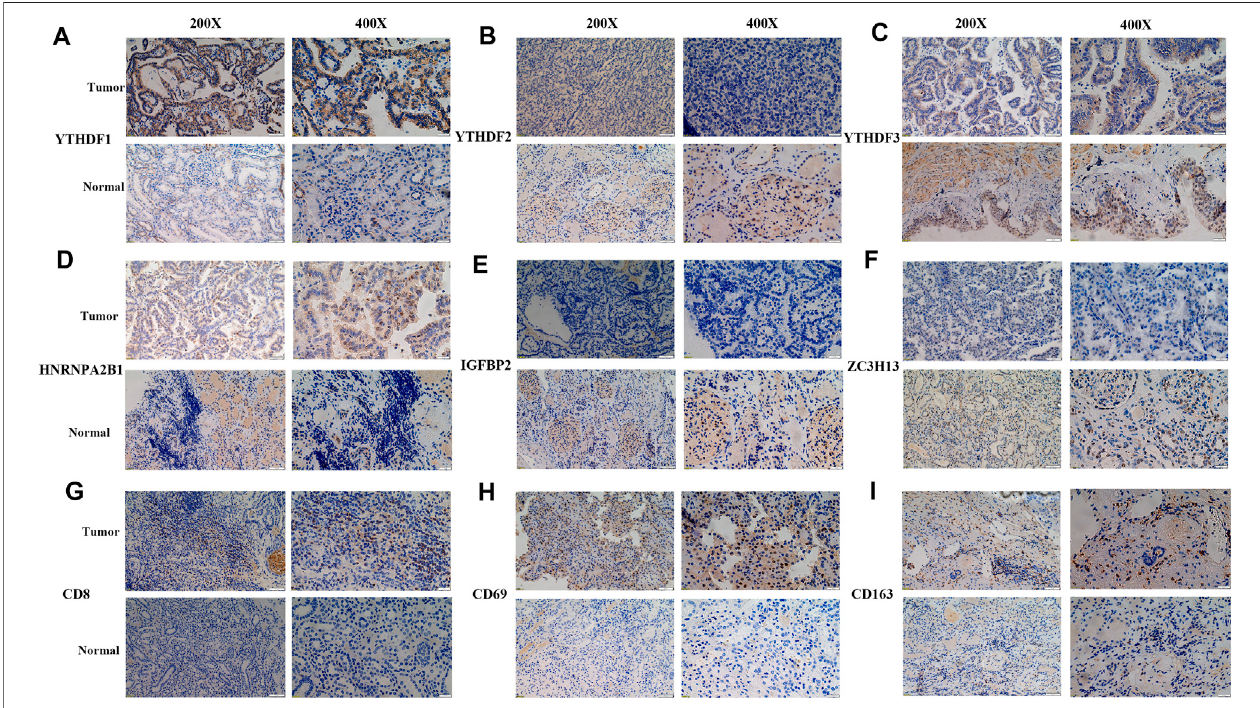
FIGURE7| RepresentativeIHCimagesofsigni fi cantm 6 AregulatorsandimmunecellmarkersinPRCCsamples. (A – F) IHCpatternsforselectedm 6 Aregulatorsin normal and tumor samples. (G – I) IHC patterns for three immune cell markers in normal and tumor samples. Bar, 50 and 200 μ m.